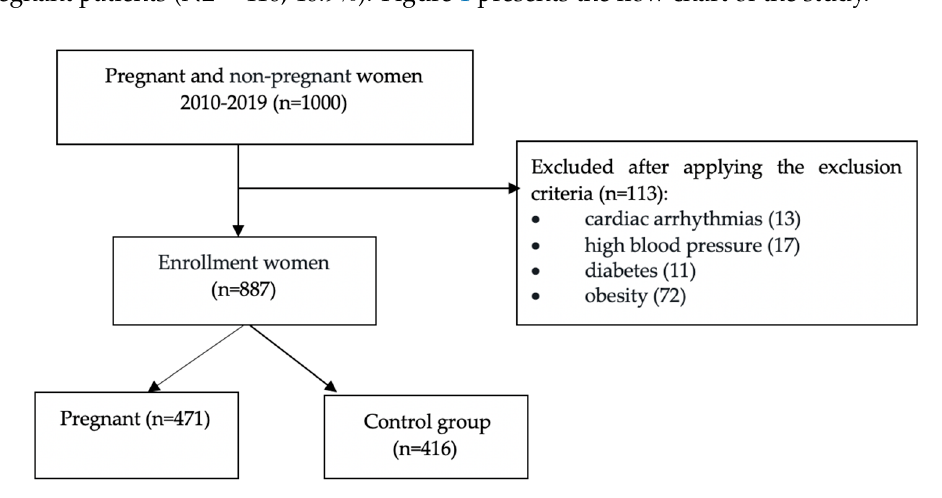
Figure 1. Flow chart of the study.